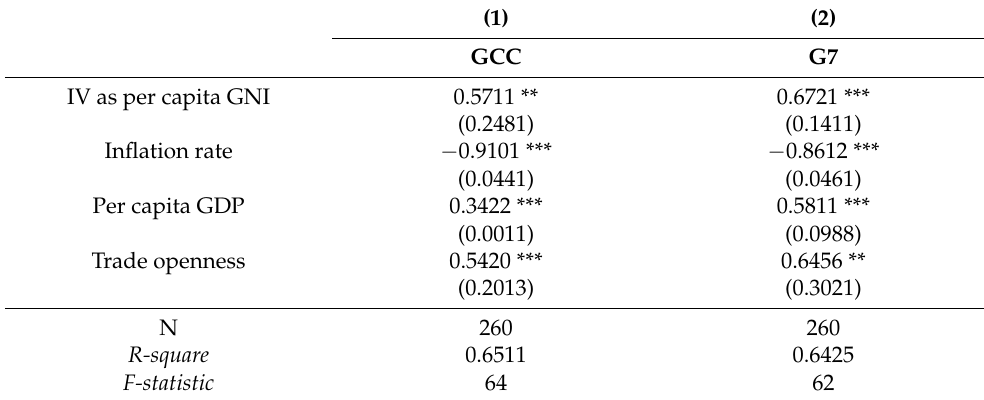
Table 2. Results of the first-stage